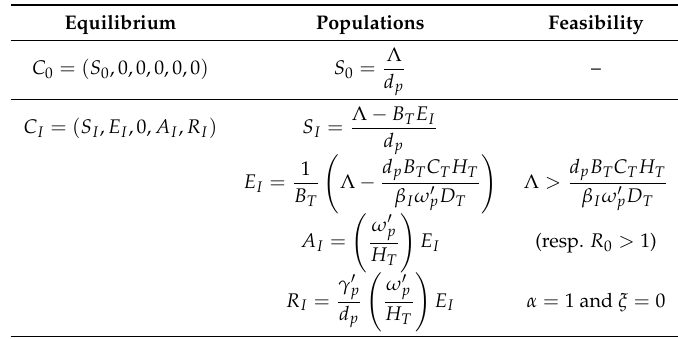
Table 1. Equilibria of the model (1) and their feasibility